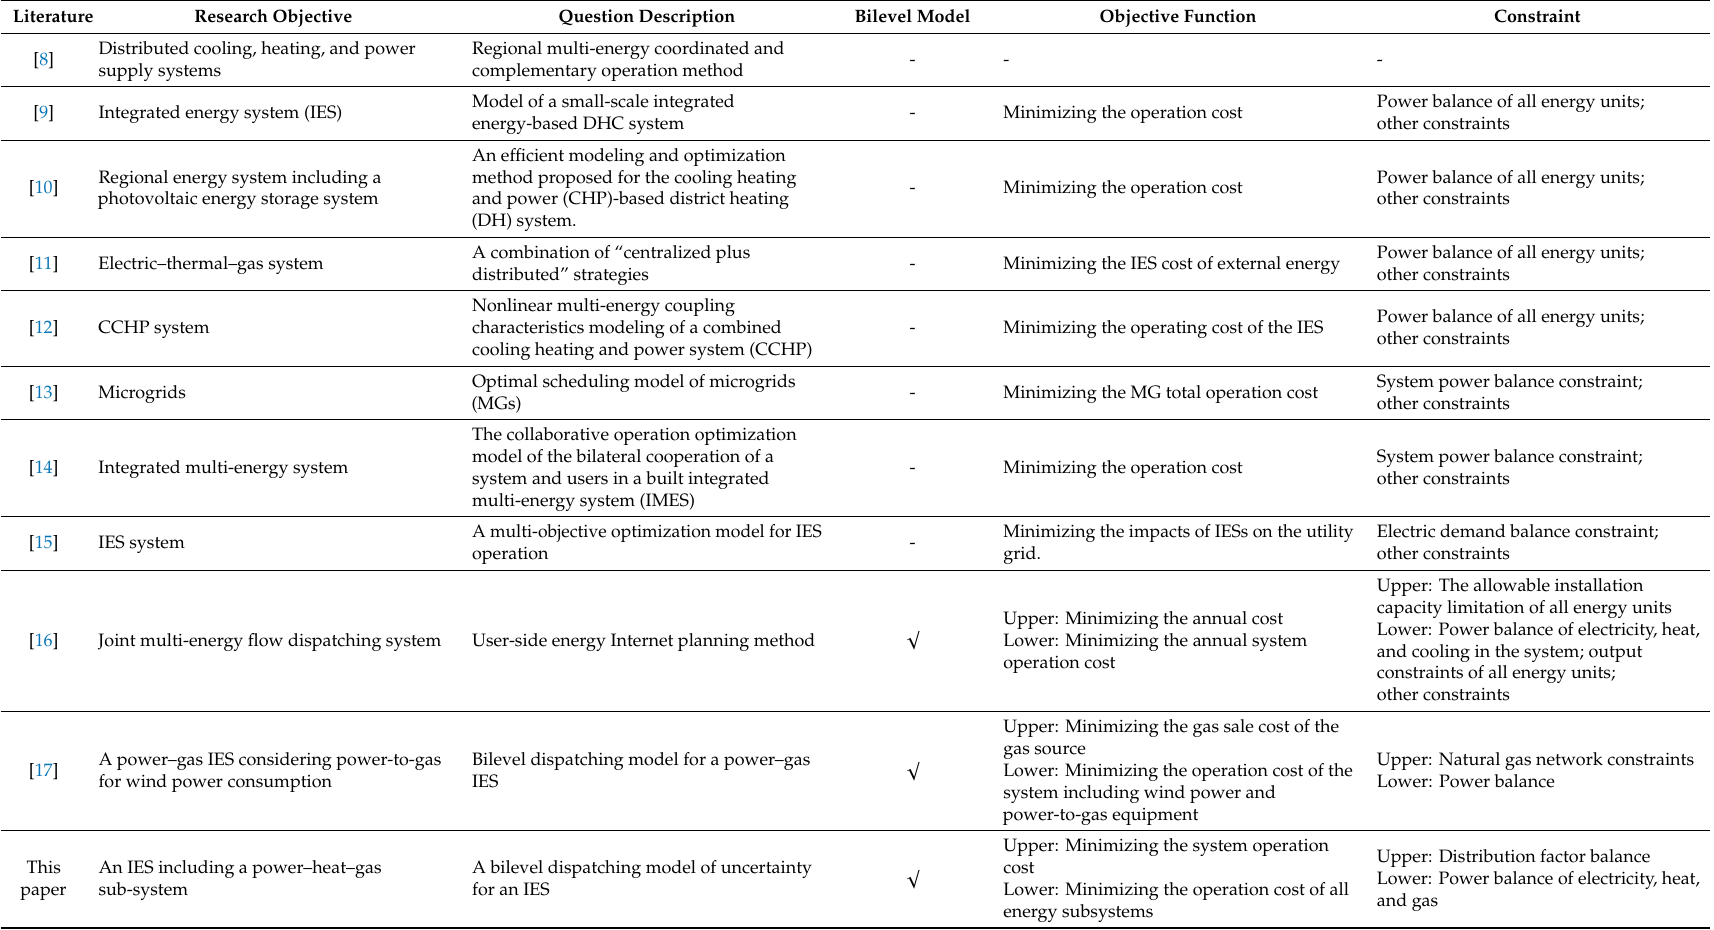
Table 1. Existing research comparison.